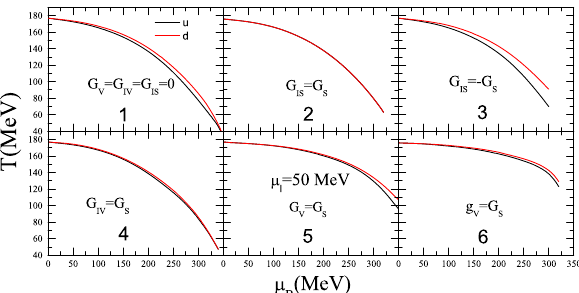
Fig. 9 Phase diagram in μ – T plane with different vector